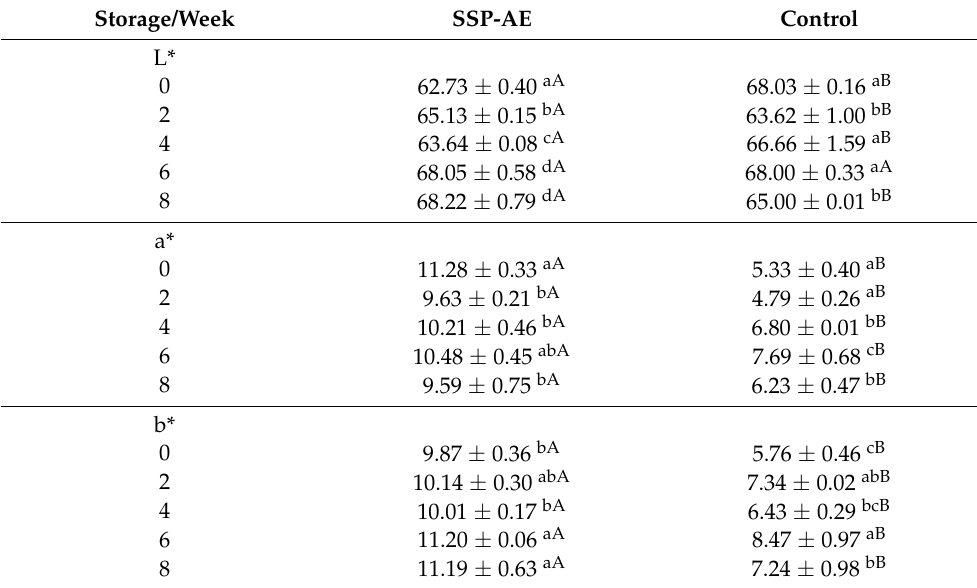
Table 2. Changes of L*, a*, and b* values of shrimp surimi products with and without astaxanthin extract during frozen storage 1 .